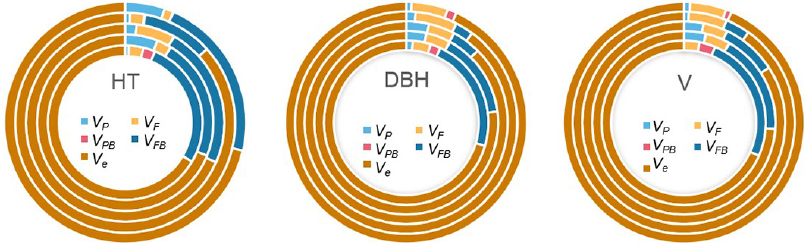
Figure 2. Variance components of different factors as percentages of phenotypic variance for growth traits at different ages in a progeny test population of N. cadamba. From the inside to the outside, the